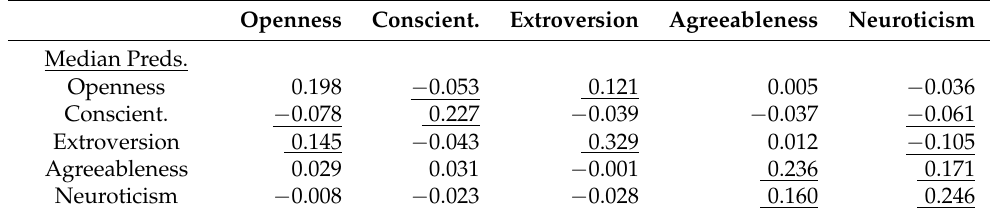
Table 7. Correlations between the gold-standard Big Five labels and predictions that use median- delimited Big Five categories as